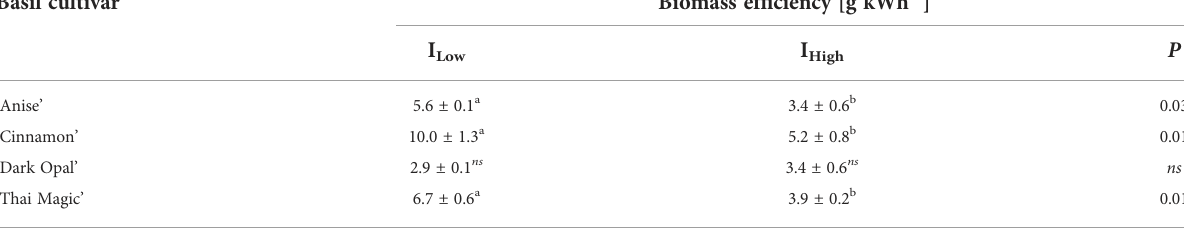
Different letters within a row indicate signi fi cant differences at p ≤ 0.05; P = signi fi cance level; ns = not signi fi cant. 1 Presented are calculated average basil fresh weights ± SD (n = 4) produced per kilowatt hour consumed under the experimental area of 1.2 m 2 by the end of the trial period (35 days after sowing) from four independent spatial replications per light